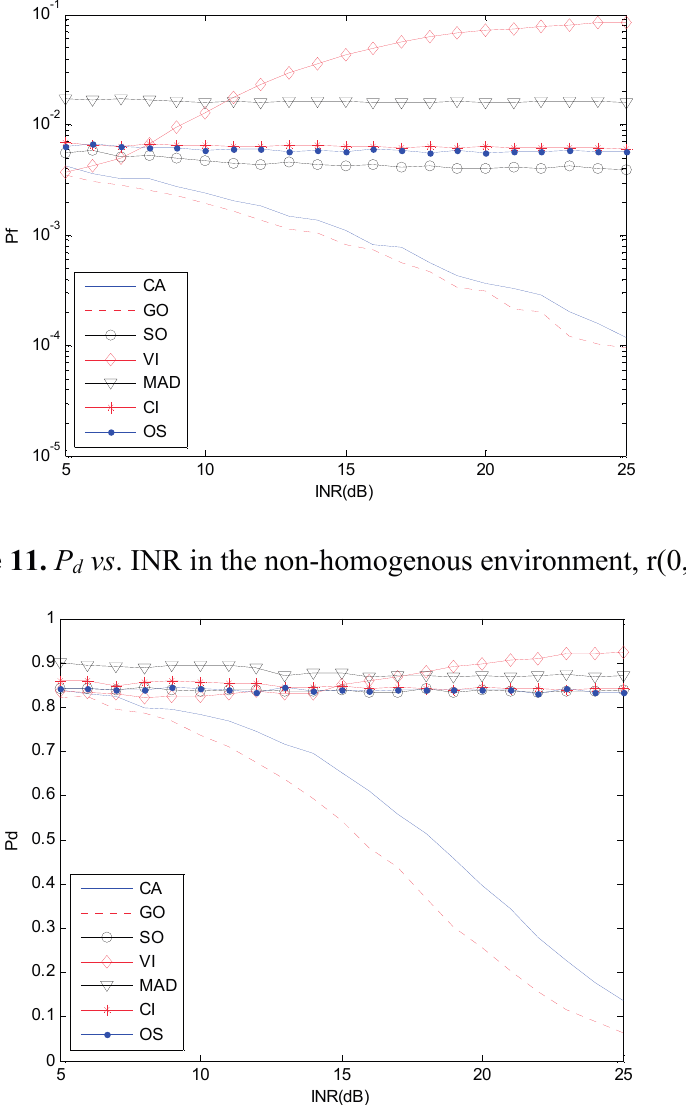
vs . INR in the non-homogenous environment, r(0,1). Figure 10. P f